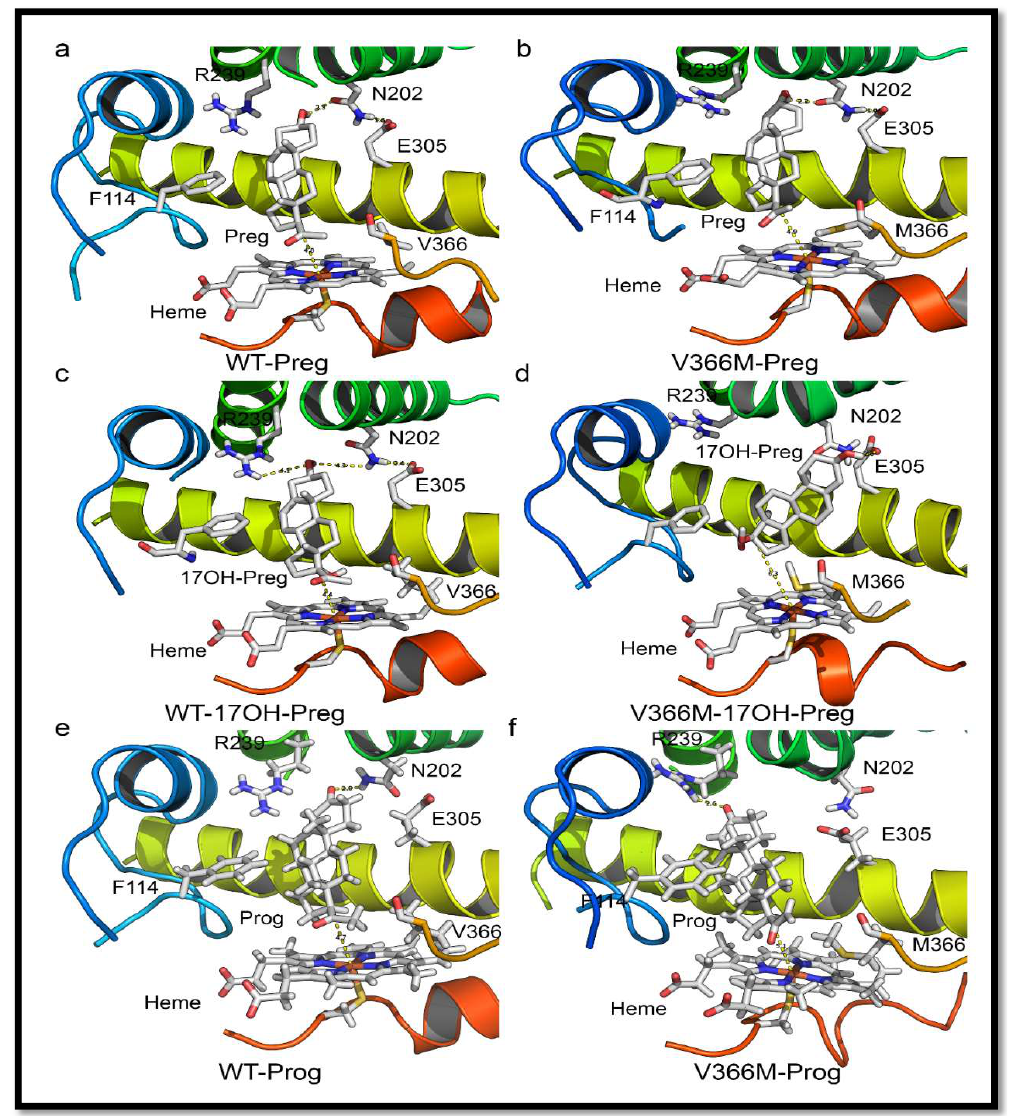
Figure 7. Structure analysis of the V366M mutation. ( a ) Binding of pregnenolone in CYP17A1 active site. Pregnenolone binds perpendicular to heme and is converted to 17OH-PREG. ( b ) Binding of pregnenolone to V366M variant of CYP17A1. Pregnenolone can still bind to V366M variant and is metabolized to 17OH-PREG. The side chain of methionine 366 in the mutant structure protrudes into the active site but still allows 17OH-PREG to exit. This is likely to slow down the reaction velocity of the 17 α -hydroxylase reaction, which was confirmed by enzyme kinetic experiments (Table 1). ( c ) Binding of 17OH-PREG to WT CYP17A1. ( d ) Docking of 17OH-PREG to V366M variant of CYP17A1. The 17OH-PREG could not bind in the proximity to heme and distances between the heme iron and C17 atom increased for the mutant enzyme (6.3 Å in the mutant vs. 4.4 Å for the WT enzyme). Increased iron-C17 distances are observed together with N202-O3 interactions which are considered undesirable for optimal binding of 17hydroxy steroids for 17,20 lyase reaction. The methionine 366 side chain in the mutant protein blocks the entry of 17 α -hydroxy steroid into the active site, resulting in loss of 17,20 lyase activity. ( e , f ) Comparison of WT and V366M variant of CYP17A1 binding to